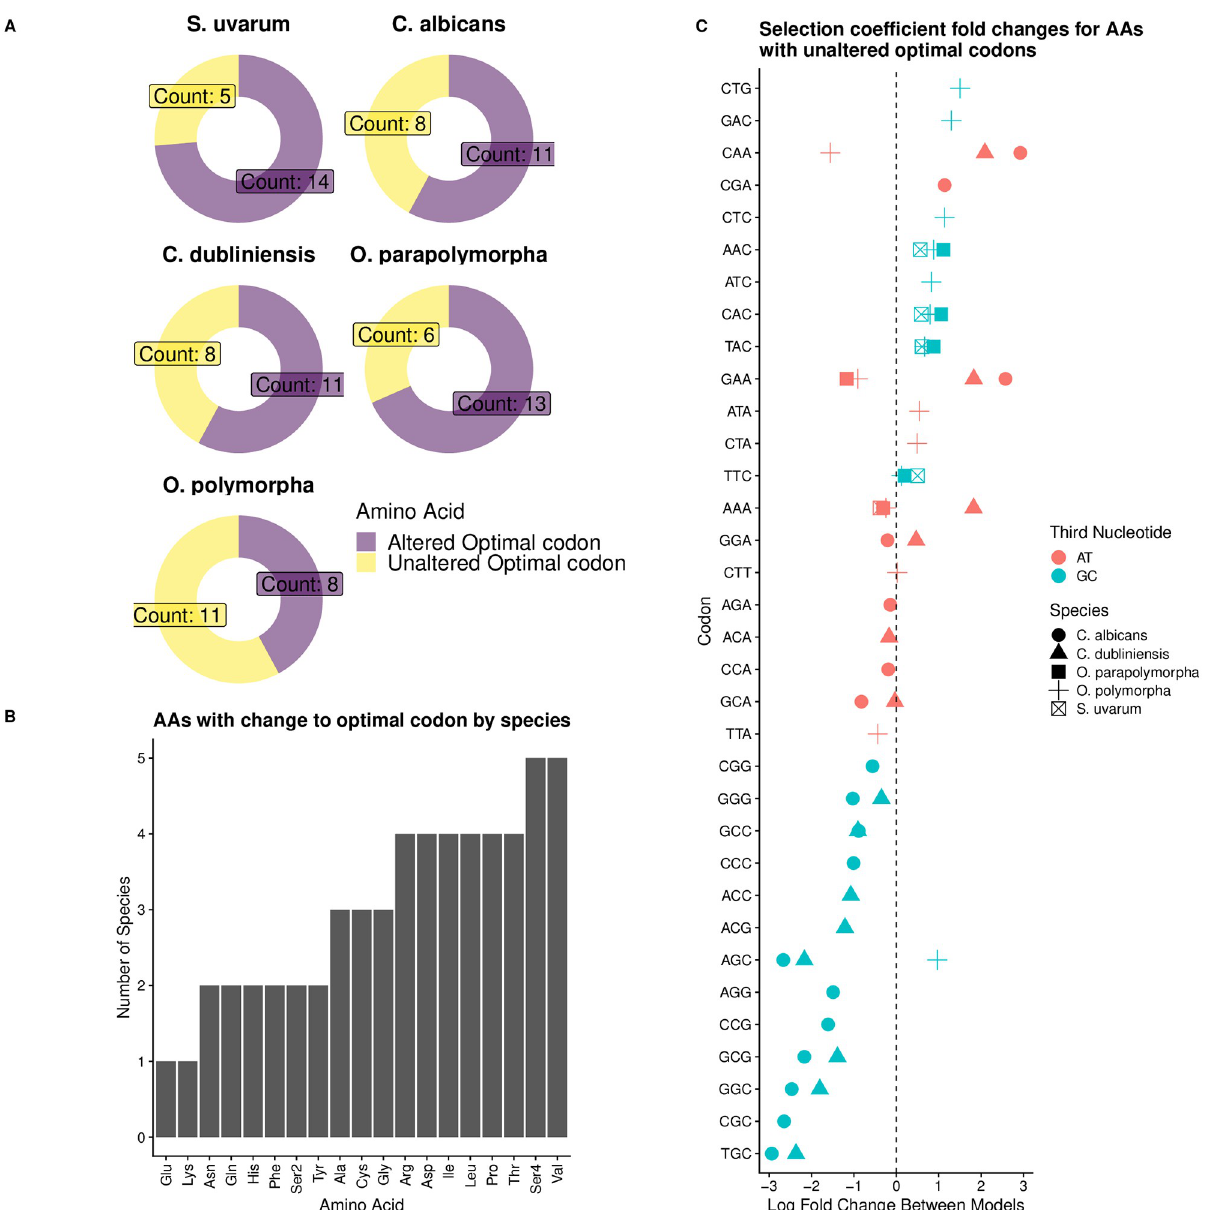
Fig 4. Failing to account for variation in non-adaptive nucleotide biases can lead to mis-identification of optimal codons. Data represent results from S. uvarum , C. albicans , C. dubliniensis , O. parapolymorpha , and O. polymorpha . (A) Number of amino acids for which the optimal codon differs between the ConstMut and VarMut models. (B) Number of species per amino acid that had a change in the identified optimal codon between the VarMut and ConstMut models. Ser4 indicates serine codons of the form TCN, where N is any nucleotide, while Ser2 indicates those of the form AGY, where Y is C or T. (C) Breakdown of fold changes for amino acids in which optimal codon is the same between ConstMut and VarMut models. Shapes indicate species, while color indicates if the third nucleotide is A/T or